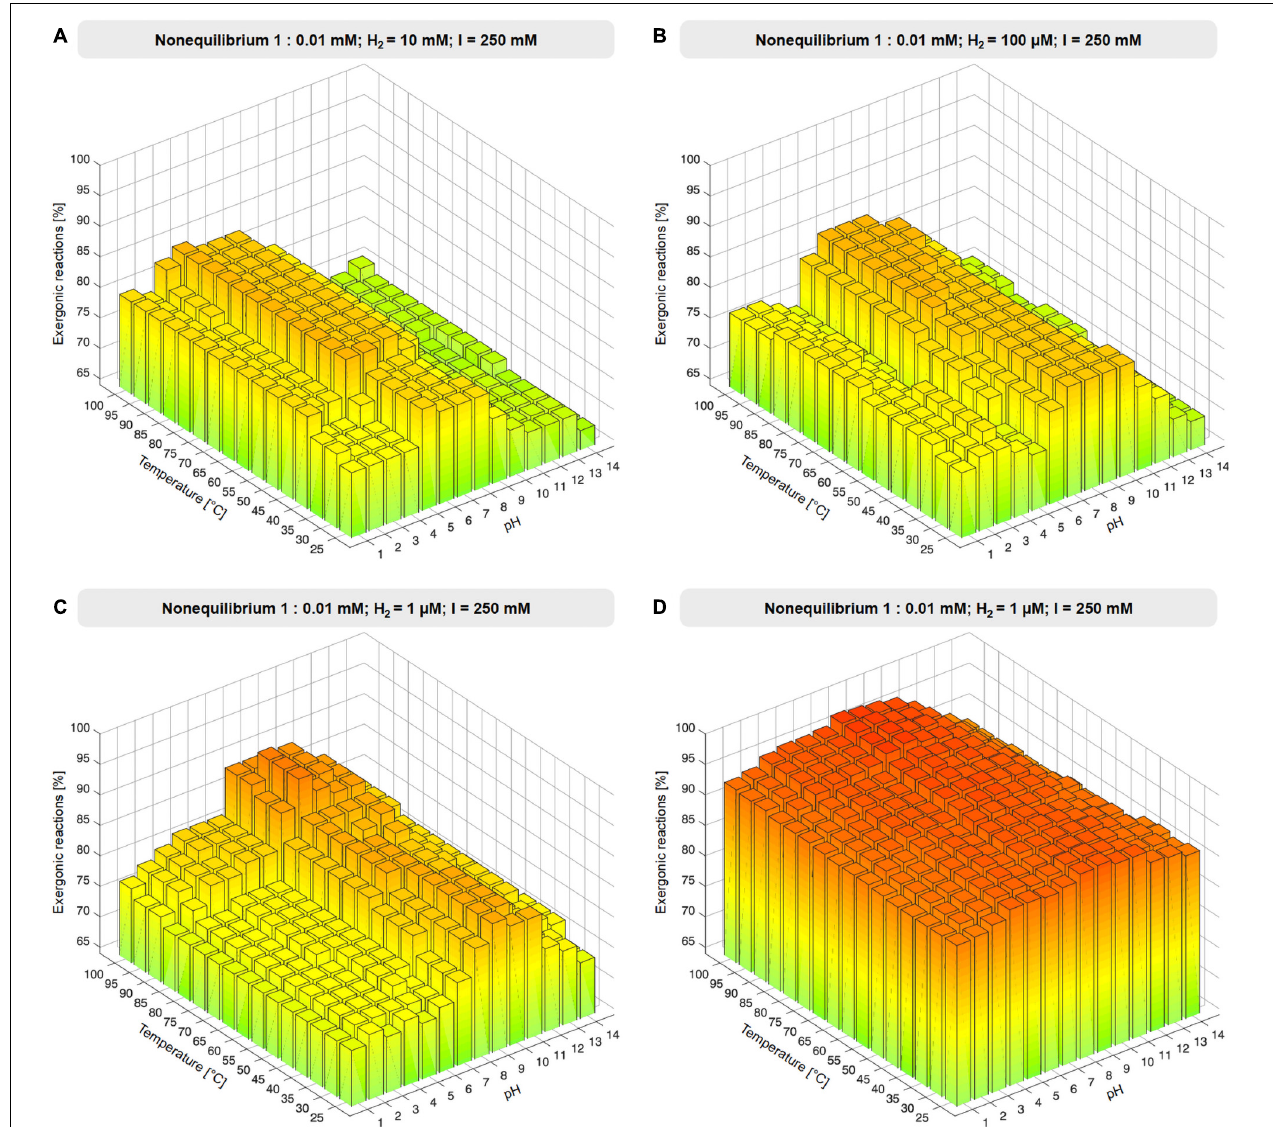
FIGURE 3 | Effect of environmental H 2 . (A–C) Proportion of exergonic reactions at 1 µ M, 100 µ M, 10 mM H 2 and 1:0.01 nonequilibrium at constant ionic strength I expressed as % of the 67 redox reactions of the core that yield values of (cid:49) G . (D) Proportion of exergonic reactions at 1 µ M H 2 and 1:0.01 nonequilibrium expressed as % of 353 reactions for which values of (cid:49) G were obtained (see also Supplementary Figure 3 and Supplementary Table 4